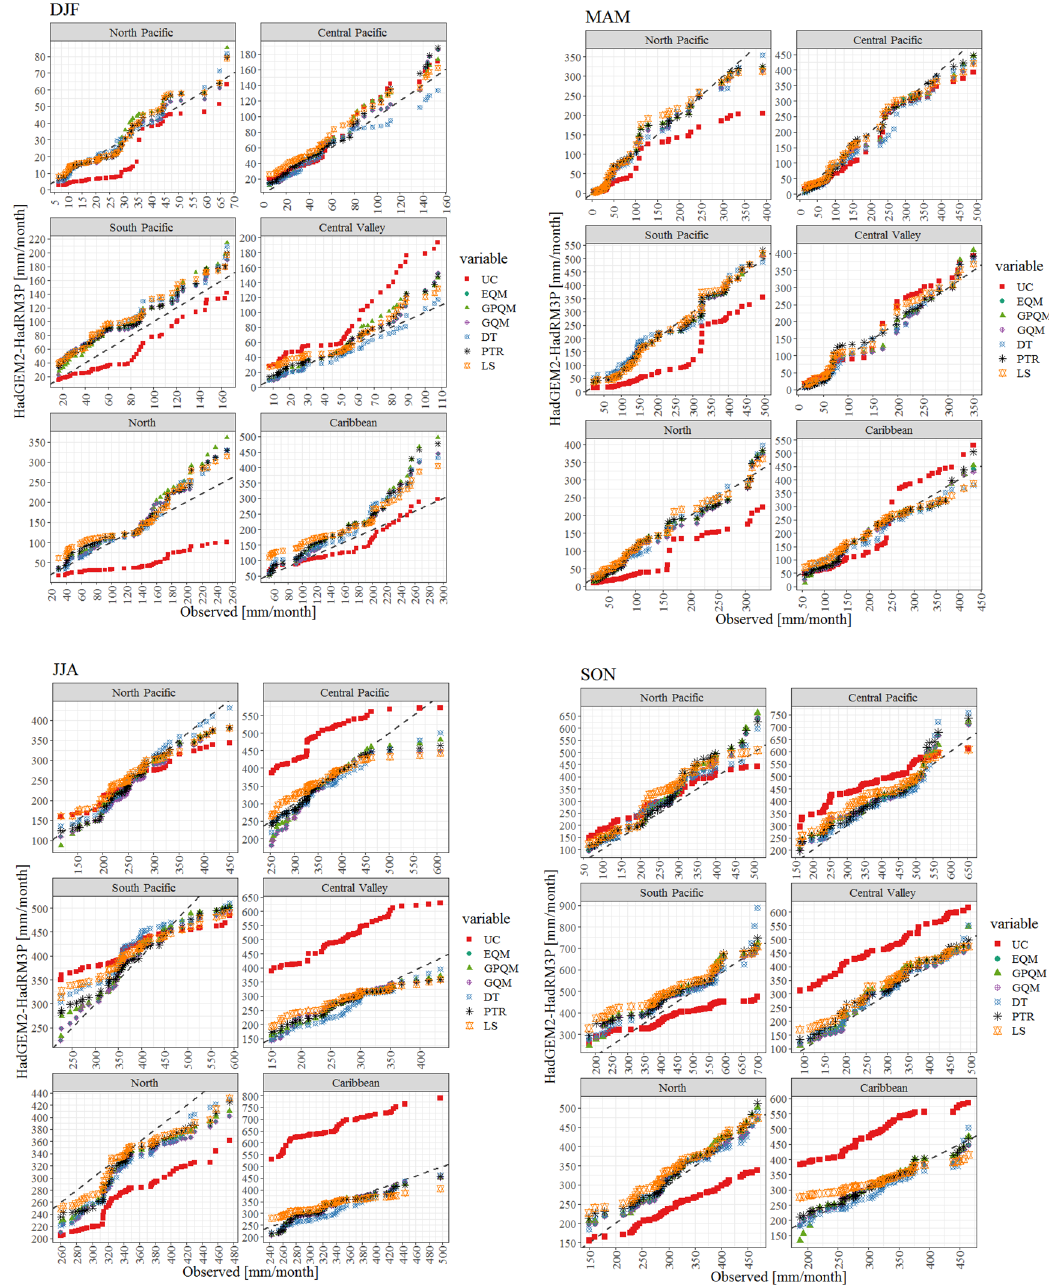
Figure 10. Spatially-averaged seasonal Q-Q plots comparing the cumulative distribution functions (CDFs) of observed and bias corrected ensemble-mean precipitation during the validation period 1981–1995 for all climatic regions of Costa